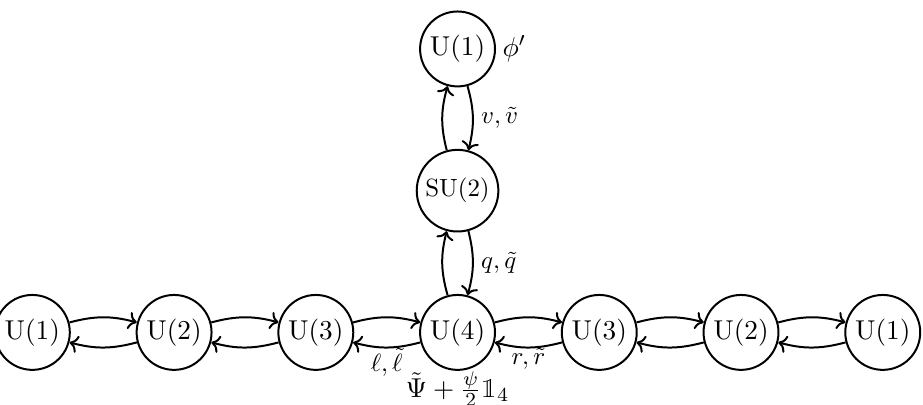
Figure 6 . Modified E 7 quiver (with φ 0 = φ + ψ the only U(1) scalar coupled to v, ˜ v